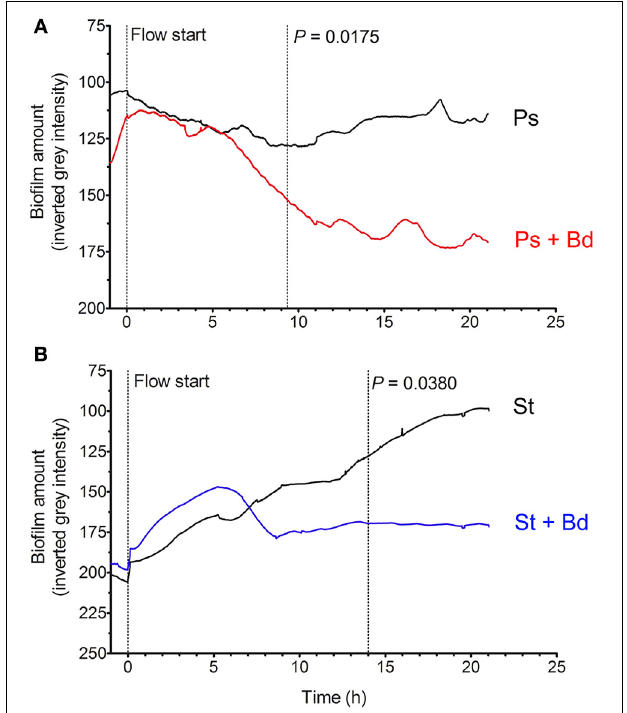
FIGURE 5 | Predation of B. bacteriovorus on “flow” prey biofilm. Biofilms of P. aeruginosa (A , red ) and S. aureus (B , blue ) were grown in 24-well microfluidic plates (BioFlux), then challenged with B. bacteriovorus suspension for 24h. Biofilm amount was expressed as mean gray intensity (from 255-white to 0-black) of each movie frame, and statistical differences were assessed by Wilcoxon Signed Rank